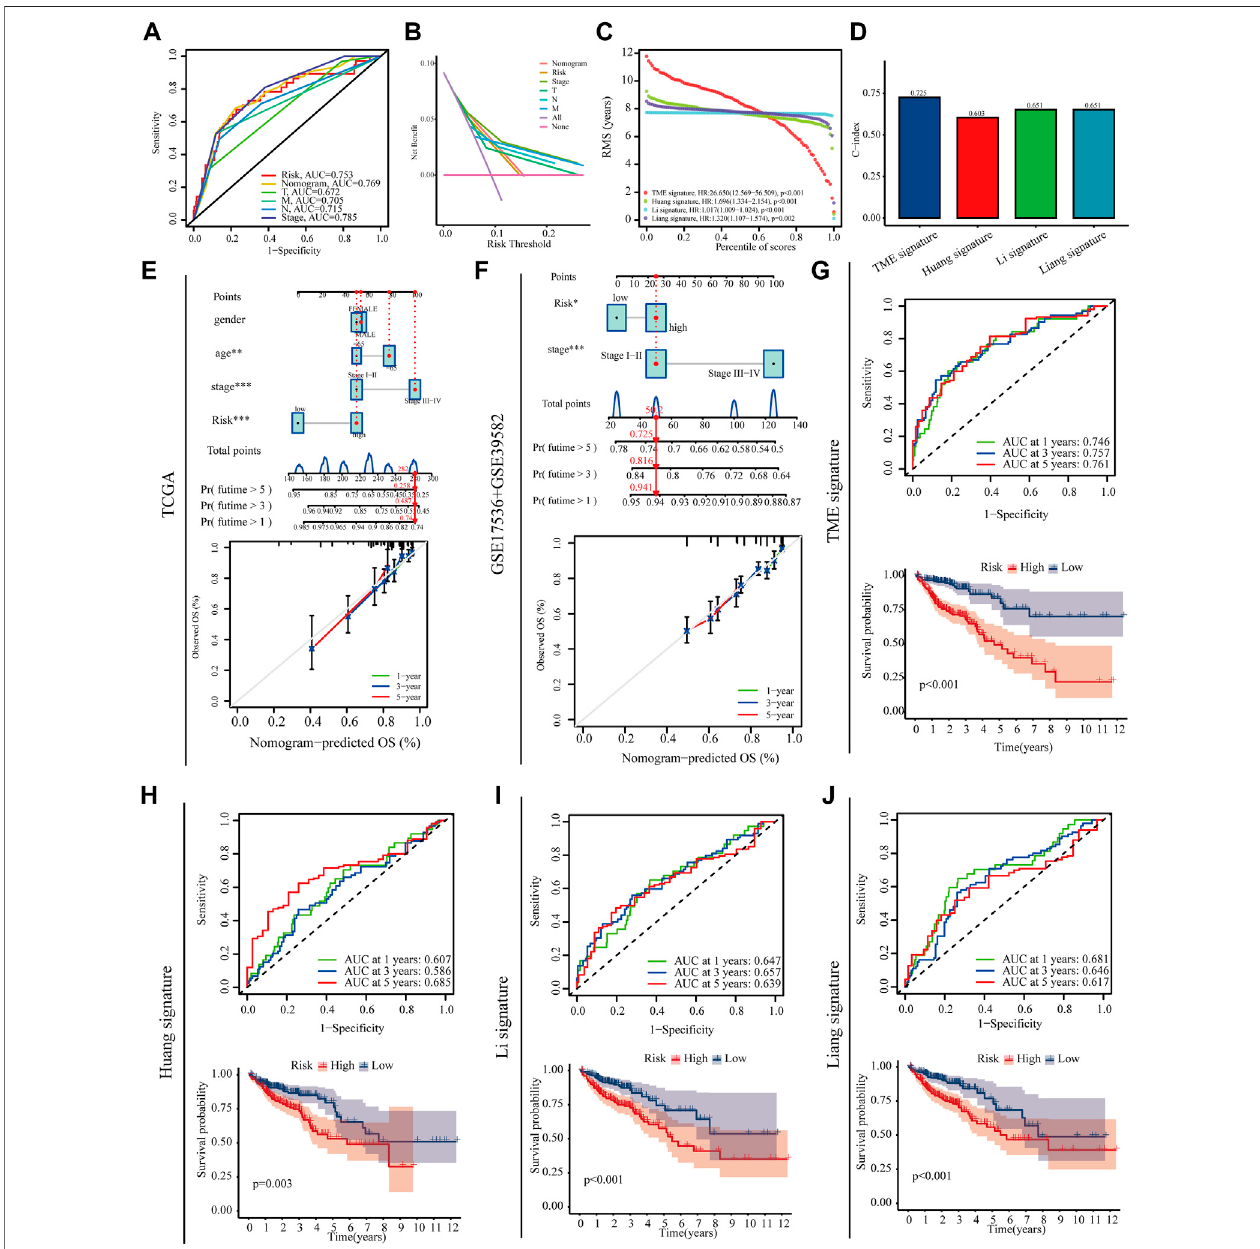
FIGURE 6 | Prognostic value of the risk model. (A,B) Roc and DCA curves were performed to validate the risk score in predicting patient ’ survival (C,D) RMS and C-index curves was used to compare the constructed model with existing models (E,F) Nomograms and calibration curves for predicting survival in colon cancer patientsat1,3and5yearsintrainingsetandtestingset (G – J) ROCandKaplan –